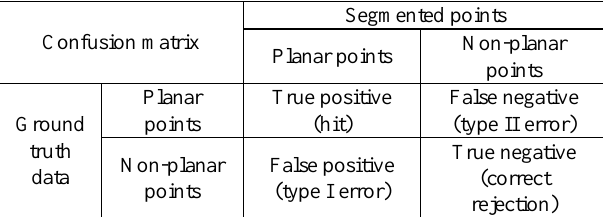
Table 2. Elements of the confusion matrix